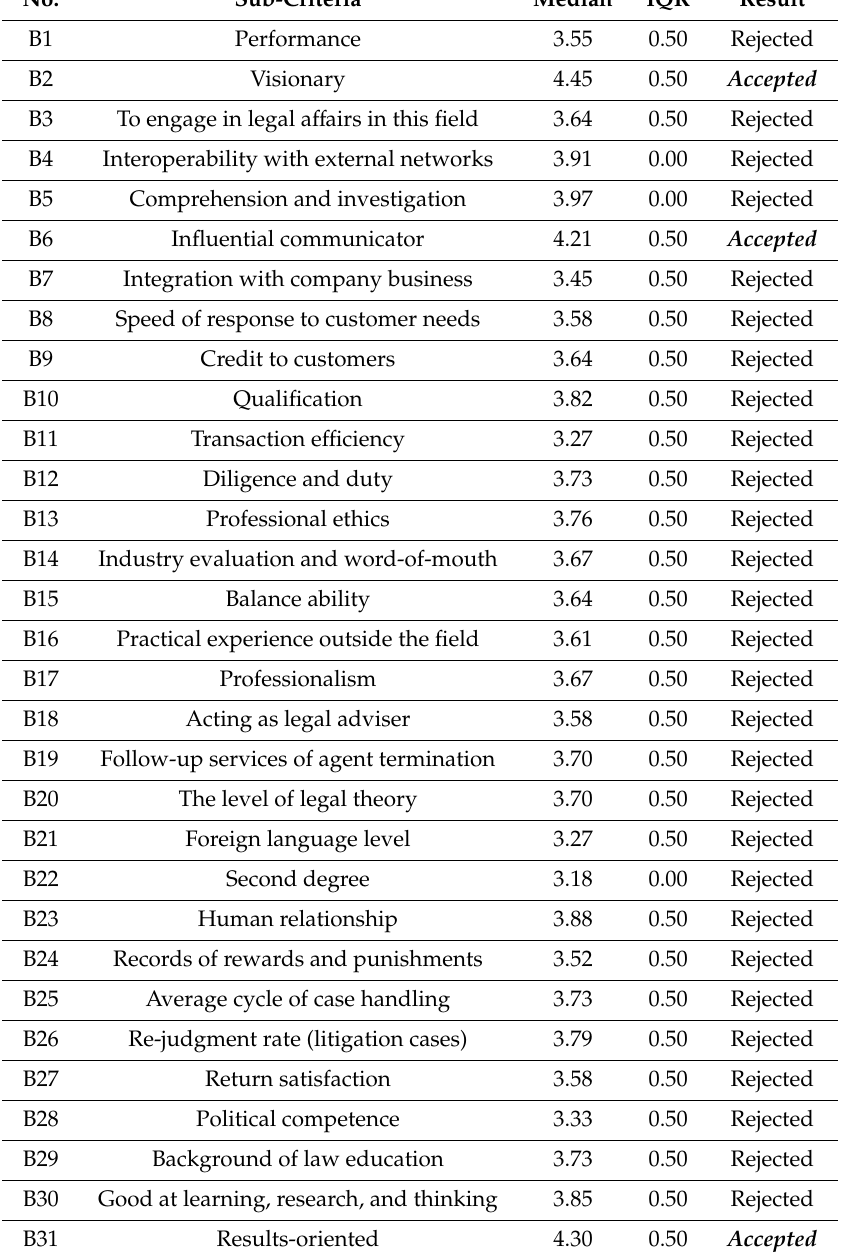
Table 4. Verified results of the backbone